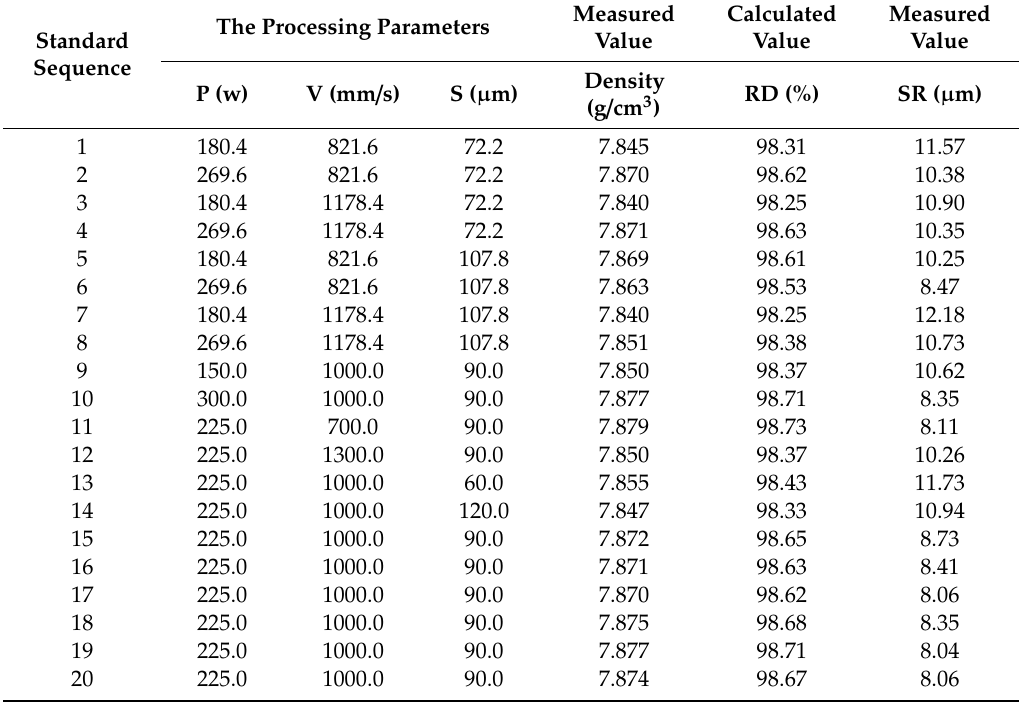
Table 3. Experimental design matrix and measured results of selective laser melted (SLMed) 316L stainless steel